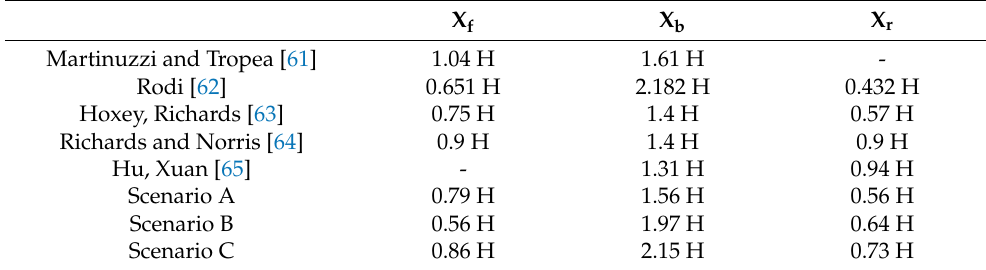
Table 3. Recirculation length of the recirculation